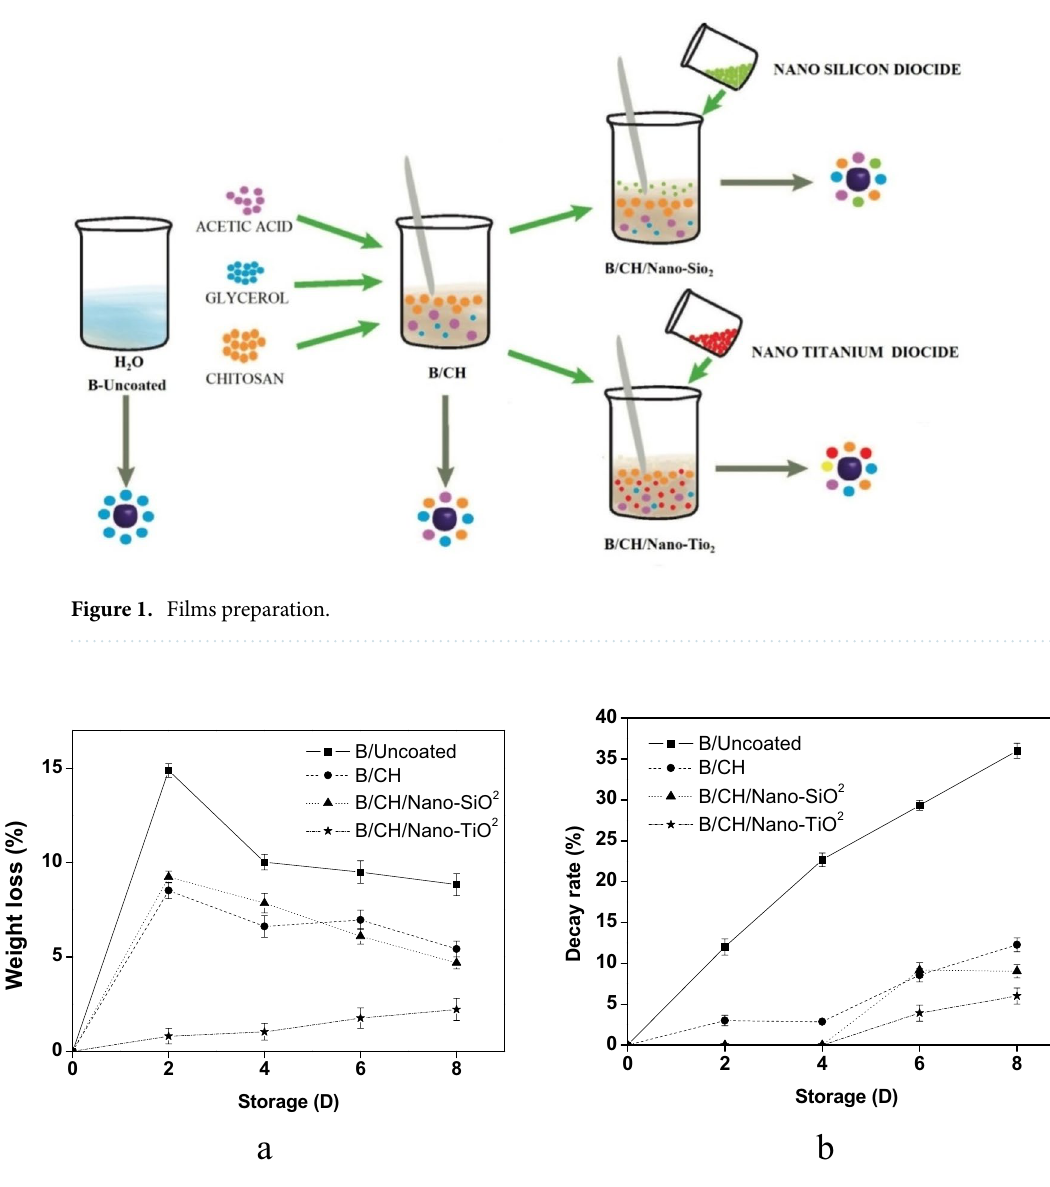
Figure 2. Effects of coating films on weight loss ( a ) and ( b ) decay